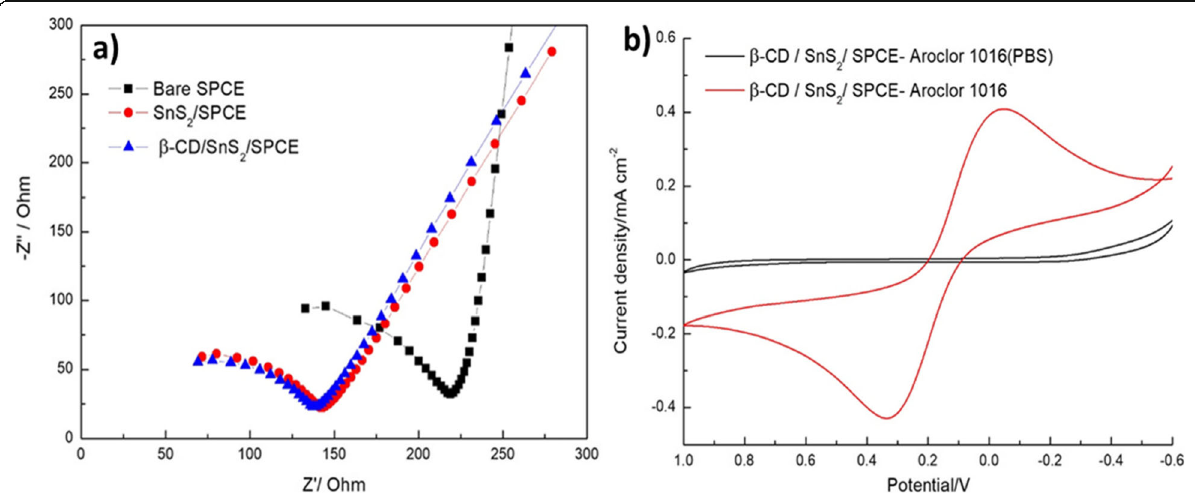
Fig. 5 a EIS spectra of different modified electrodes: bare SPCE, SnS 2 /SPCE, and β -CD/SnS 2 /SPCE. b β -CD/SnS 2 /SPCE modified electrode in PBS (pH = 7.4) (black) and 3 mM yellow blood salt, 3 mM red blood salt, 0.1 M KCl solution (red) in the mixture solution of 80 μ M PCB Aroclor